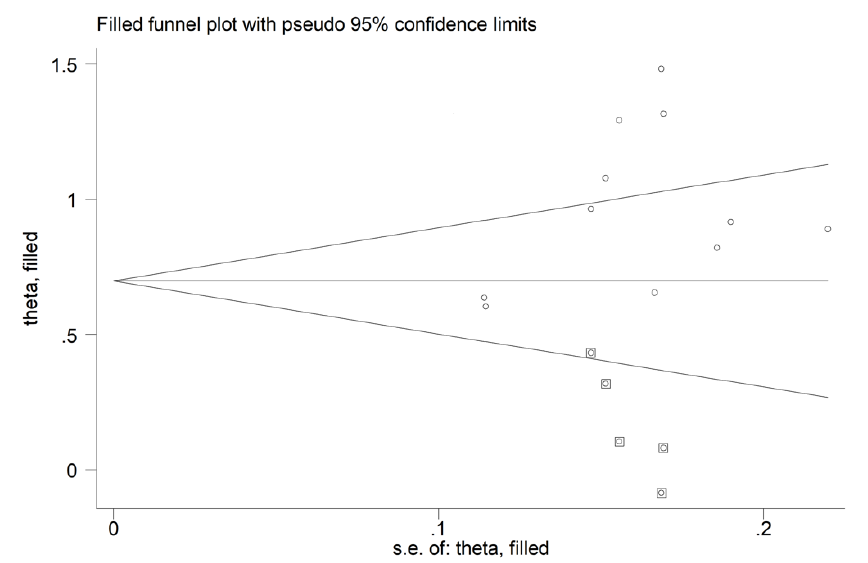
Figure 14. Funnel plot of studies investigating the association between the red cell distribution width and rheumatoid arthritis after trimming and filling. Dummy studies and genuine studies are